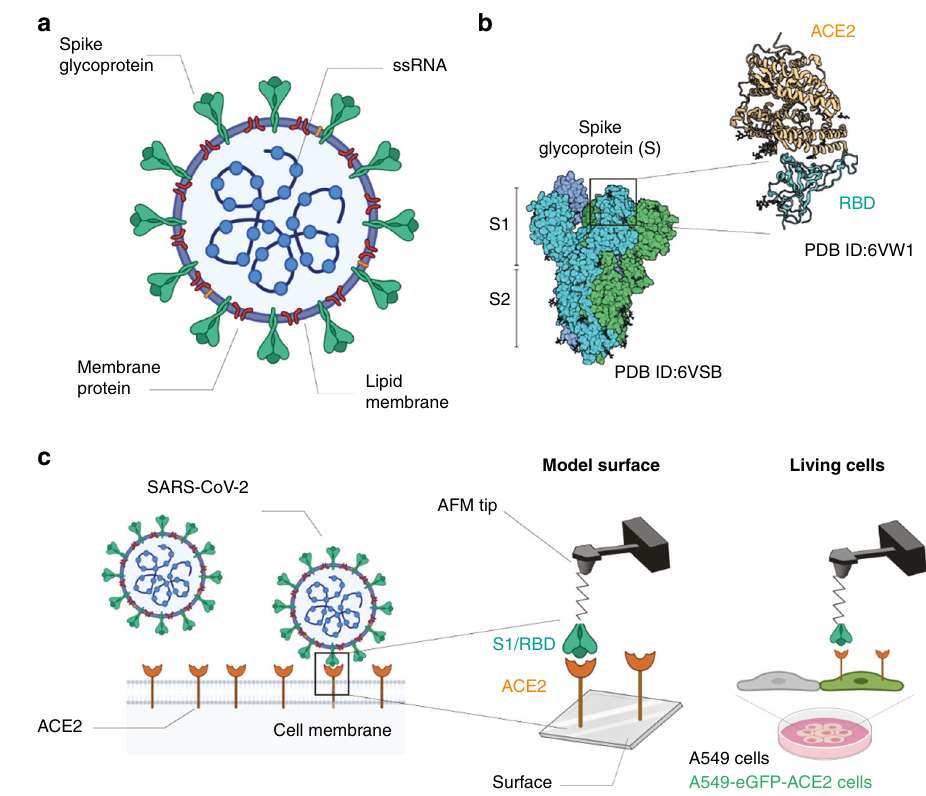
Fig. 1 Probing SARS-CoV-2 binding to the ACE2 host receptor. a Schematic of a SARS-CoV-2 particle, an enveloped ssRNA virus expressing at its surface the spike glycoprotein (S) that mediates the binding to host cells. b Structural studies have previously obtained a complex between the receptor-binding domain (RBD, a subunit of the S glycoprotein) and the angiotensin-converting enzyme 2 (ACE2) receptor. c Schematic of probing SARS-CoV-2 binding using atomic force microscopy (AFM). The initial attachment of SARS-CoV-2 to cells involves speci fi c binding between the viral S glycoprotein and the cellular receptor, ACE2. The interactions are monitored by AFM on model surfaces, where the ACE2 receptor is attached to a surface and the S1 subunit or the RBD onto the AFM tip, and on A549 living cells expressing or not fl uorescently labeled